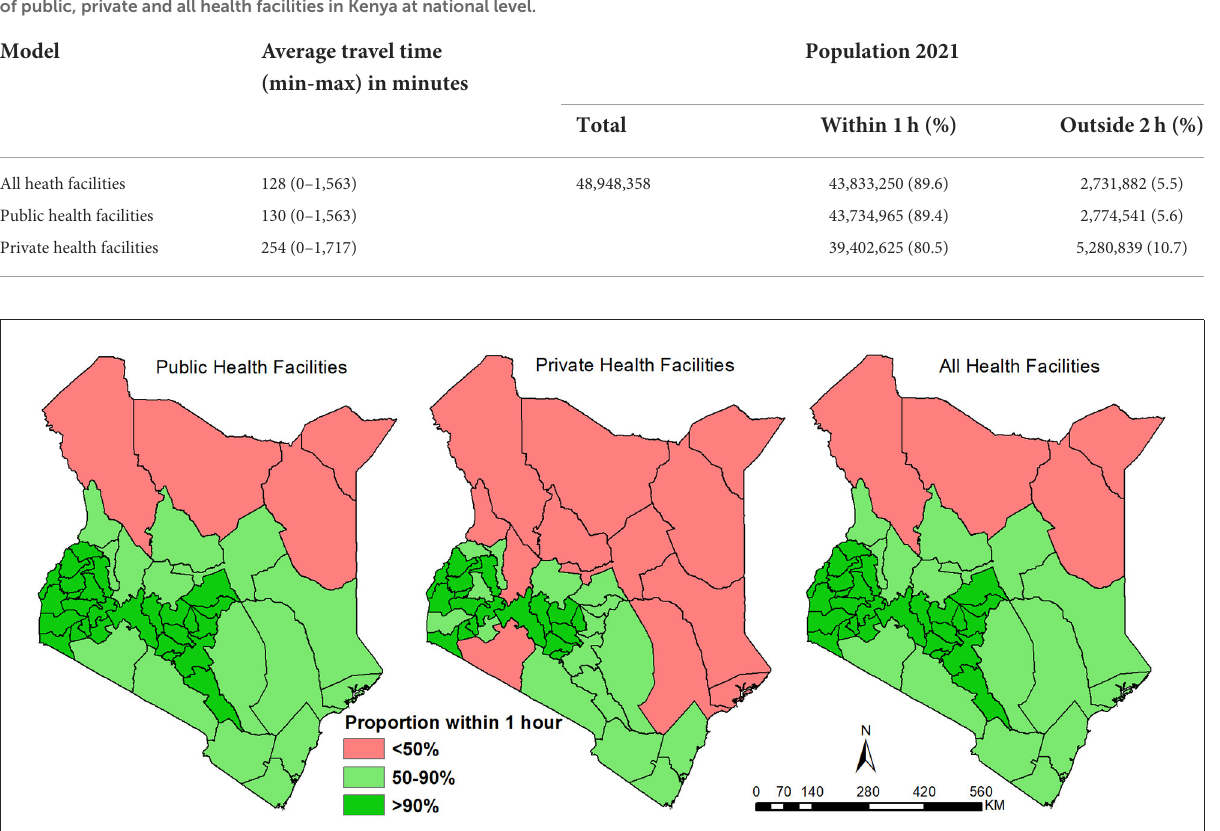
TABLE 4 Distribution of all health facilities and summary of populations within 1h of the nearest facility by urban and non-urban spatial extents. Area Health facilities (%) Population within 1 h